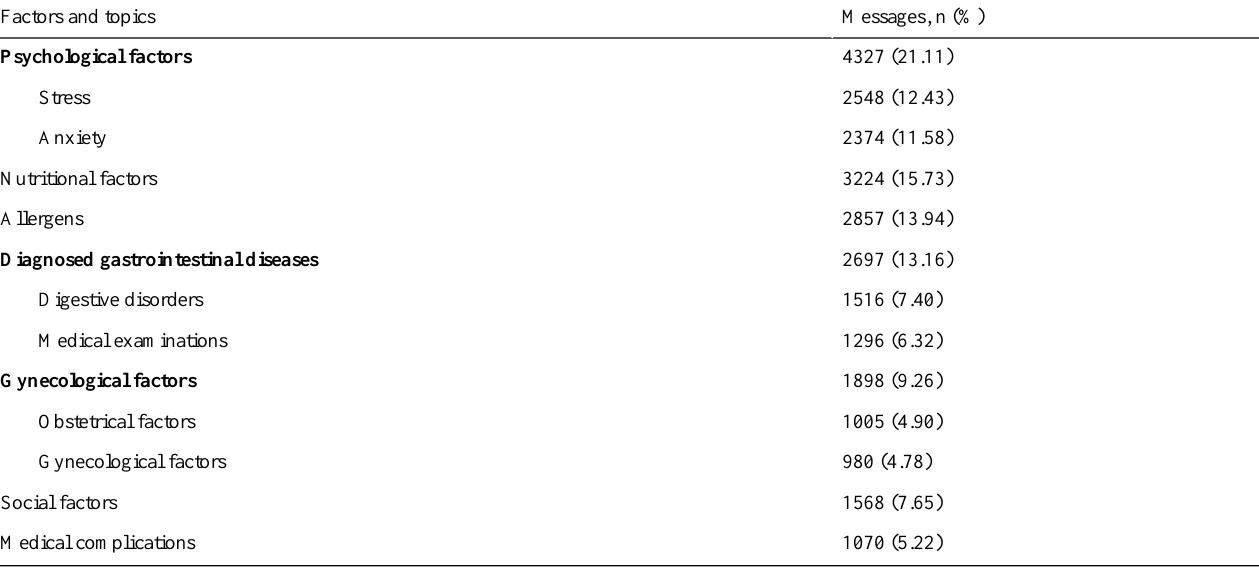
Table 5. Perceived factors of gastrointestinal discomfort. Proportions are calculated among the messages with causality terms (20,500 messages).